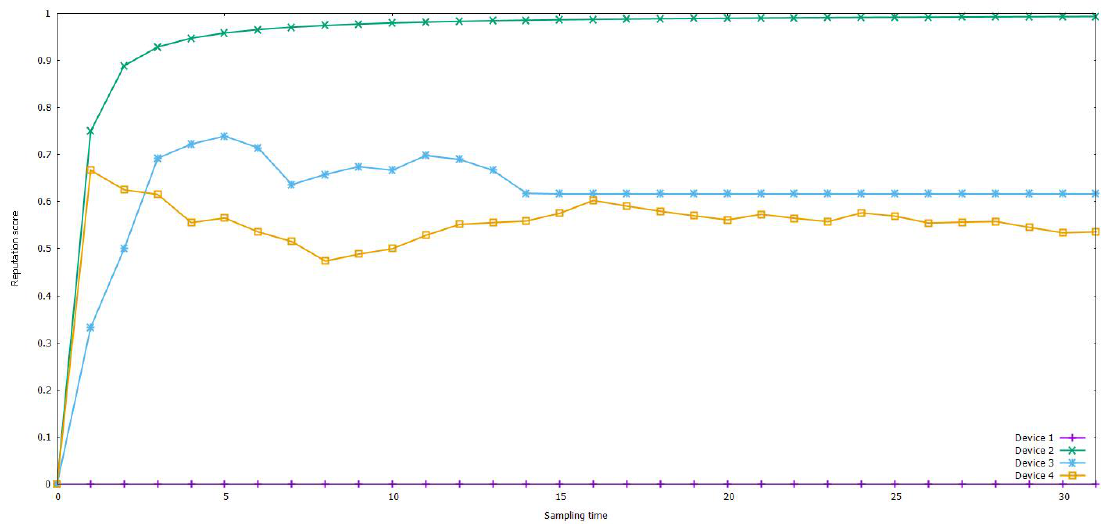
Figure 7. Sensor value reputation of each device, obtained in test